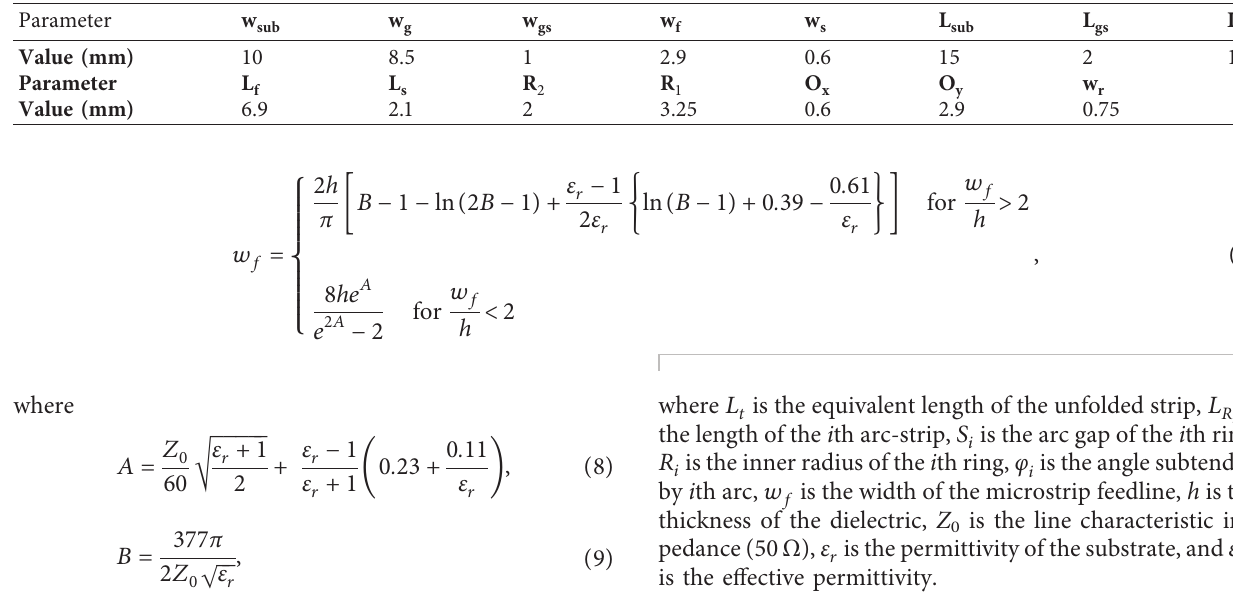
� 241 . 9 o and φ � 170 . 1 o 1 2